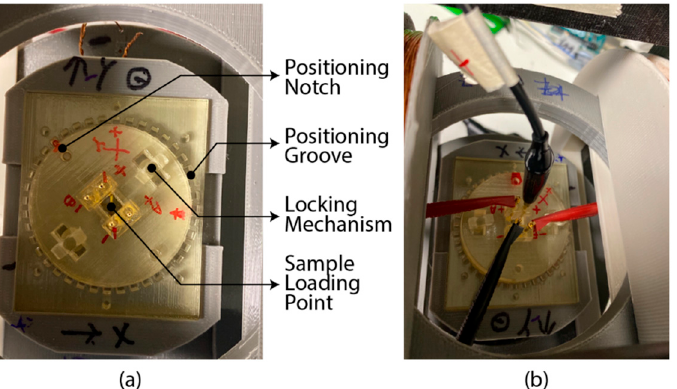
Figure A3. Sensor holder mounted on the 3-axis Helmholtz coil setup for measurement. ( a ) Photo- graph indicating the sample loading point. ( b ) Electrical connection to the measurement setup.